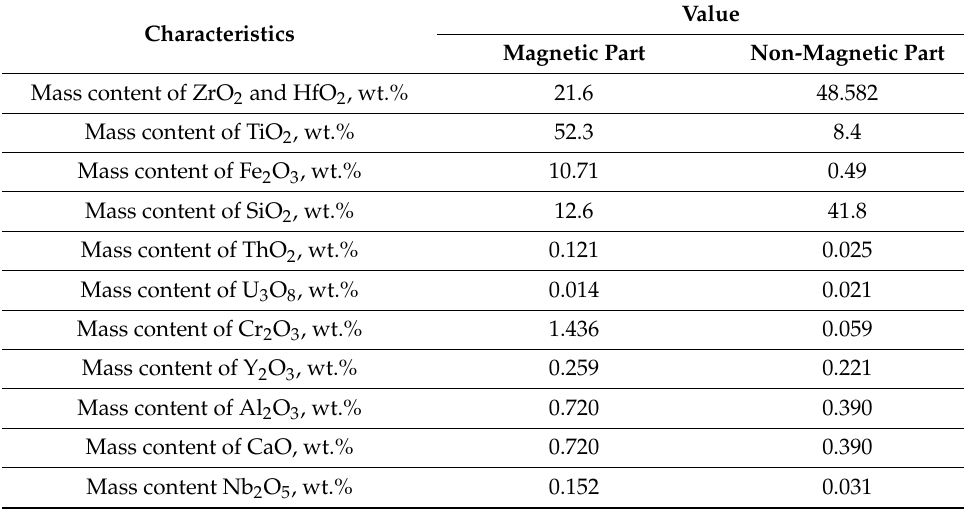
Value Magnetic Part Non-Magnetic Part